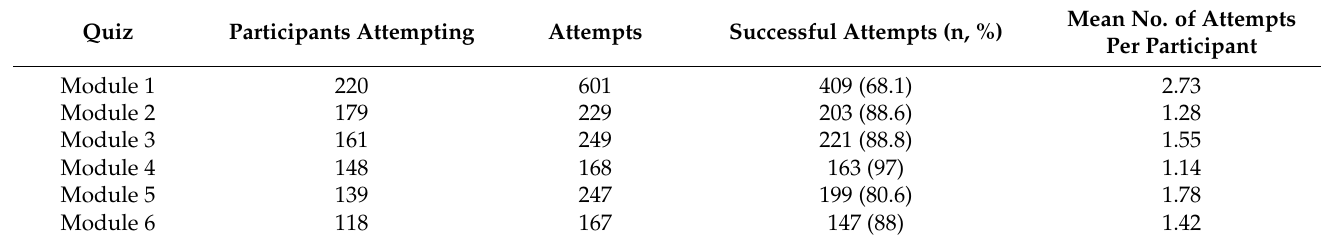
Table 3. Participants’ Attempts at Completing Module Quizzes (N = 578).